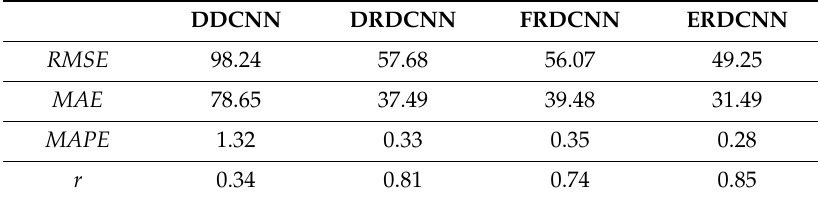
Table 3. Performance of the four models on the 100 test images.